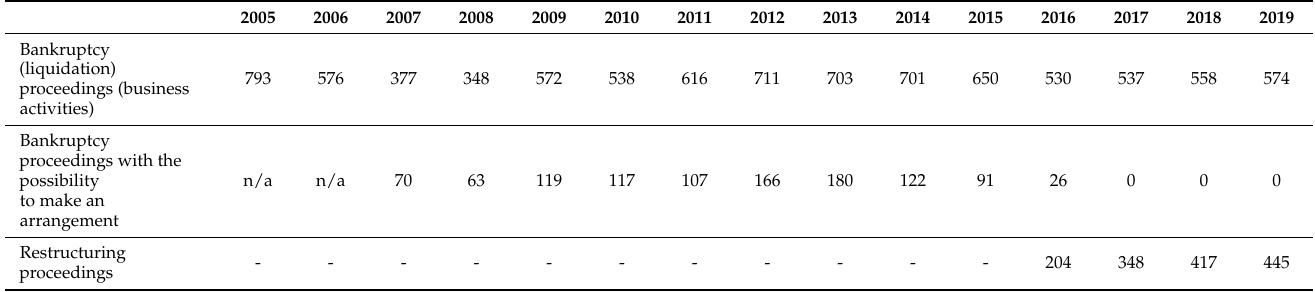
Table 1. Bankruptcies and restructurings in Poland in 2005–2019.